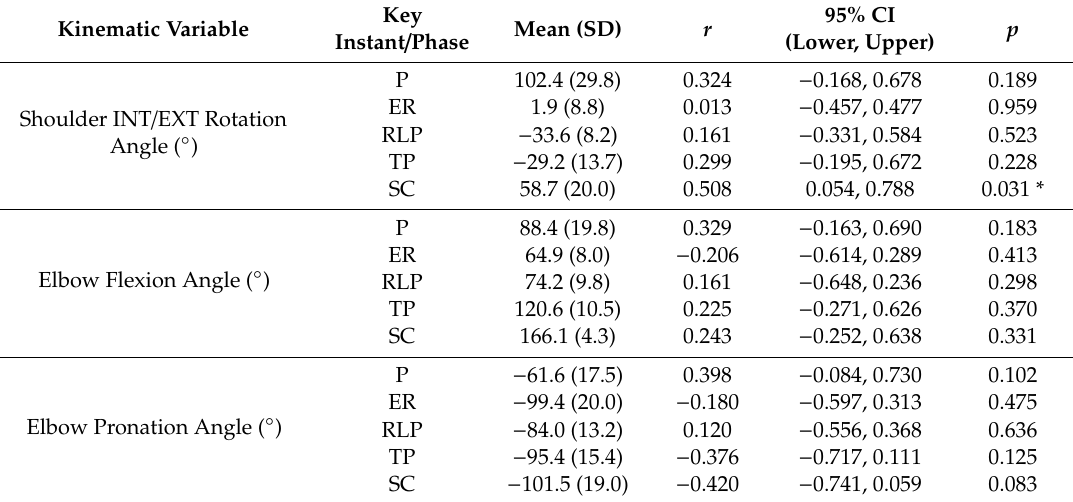
Table 3. Pearson product moment correlation (r) between joint angles of the shoulder and elbow at key instants and shuttlecock speed. Kinematic